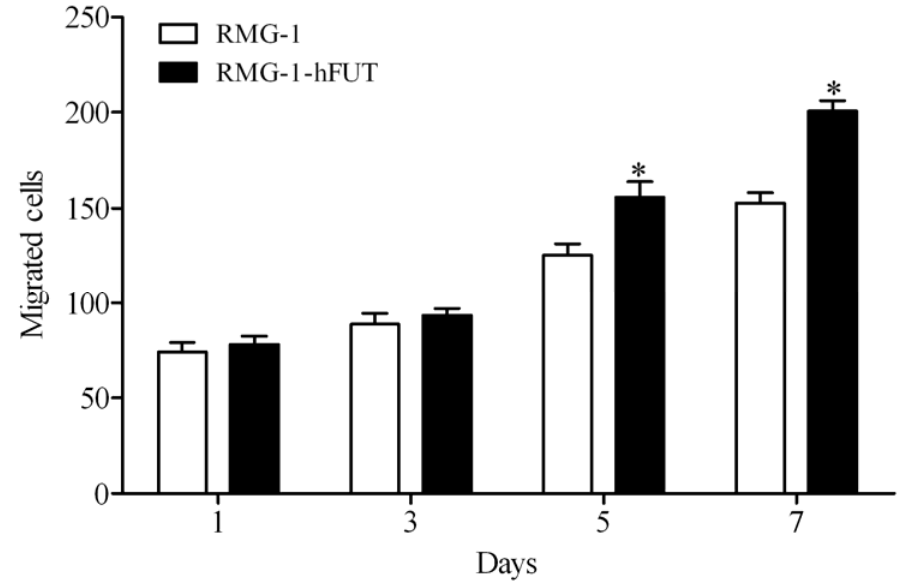
Figure 1. In vitro migration assay was performed by using 24-well transwell units coated with Matrigel. Invaded cell number was determined after cell seeding. * P <